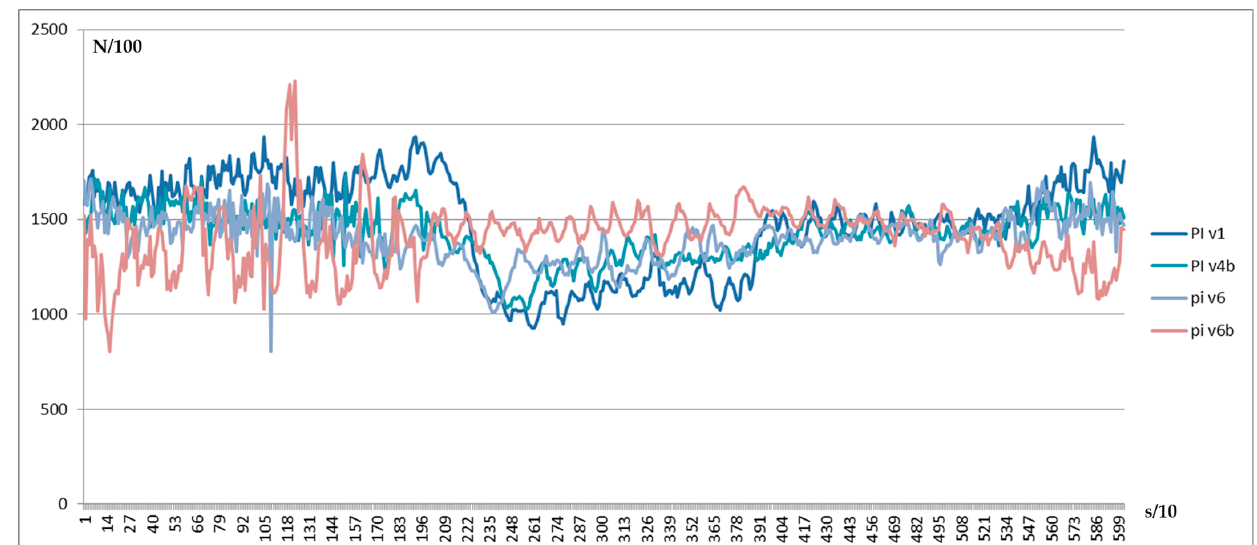
Figure 18. Limited control system.